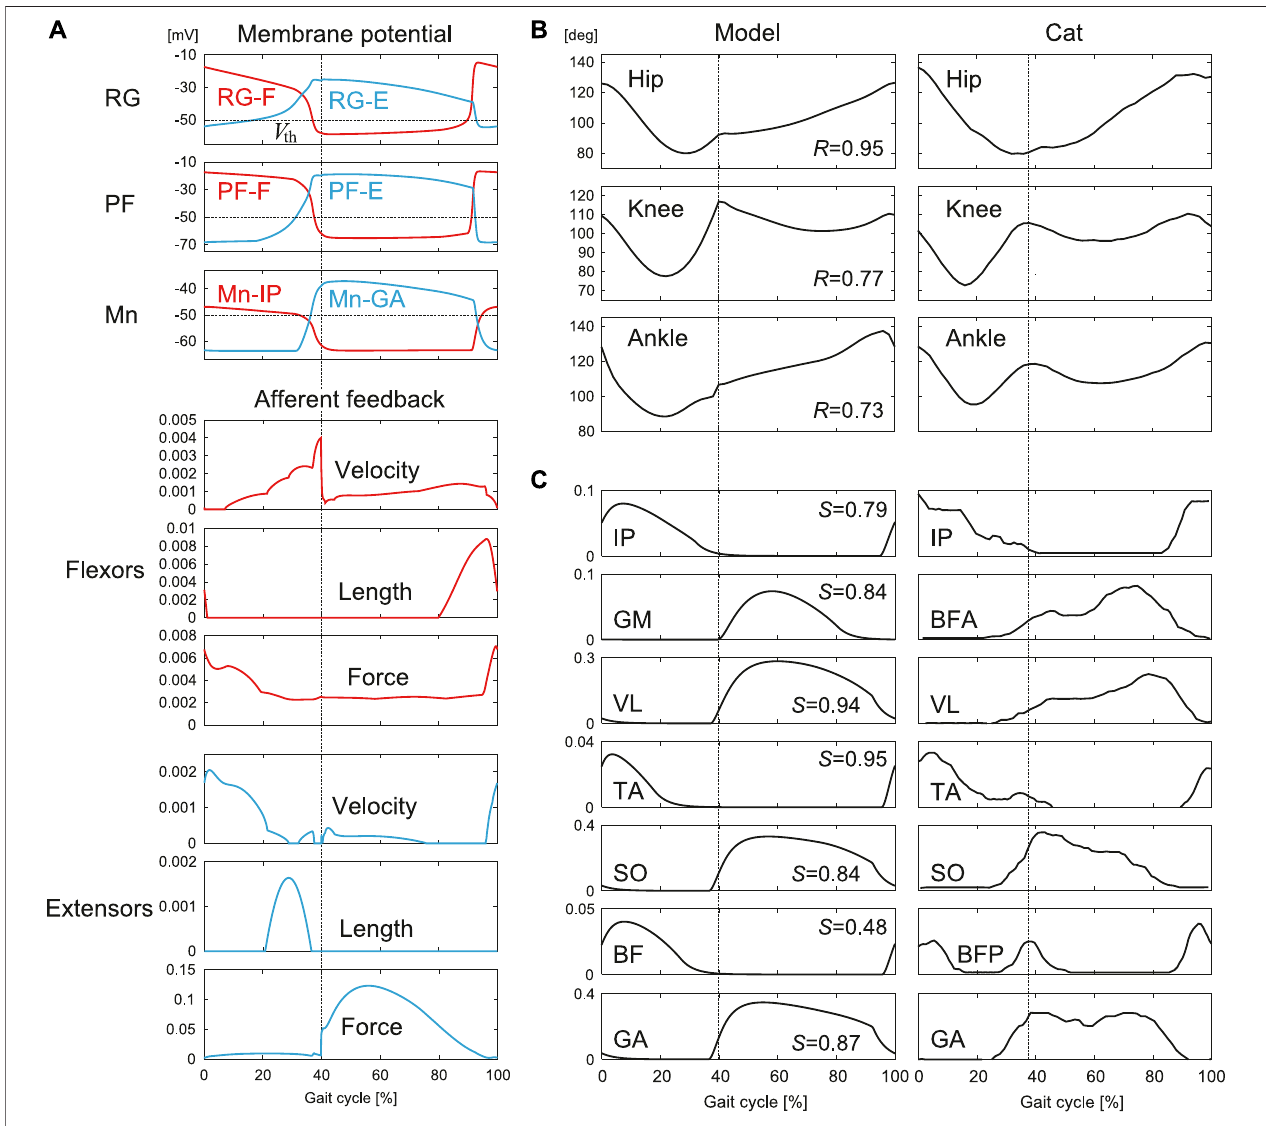
FIGURE 5 | Simulation results for normal walking obtained by the optimization: (A) Membrane potentials of CPG neurons and afferent feedback from fl exor and extensor muscles. (B) Joint angles and (C) muscle activations compared with measured data in cat [adapted from Prilutsky et al. (2016)]. R is the correlation coef fi cient and S is the cosine similarity. Liftoffs are represented by 0 and 100% in the gait cycle. Vertical lines indicate touchdowns.